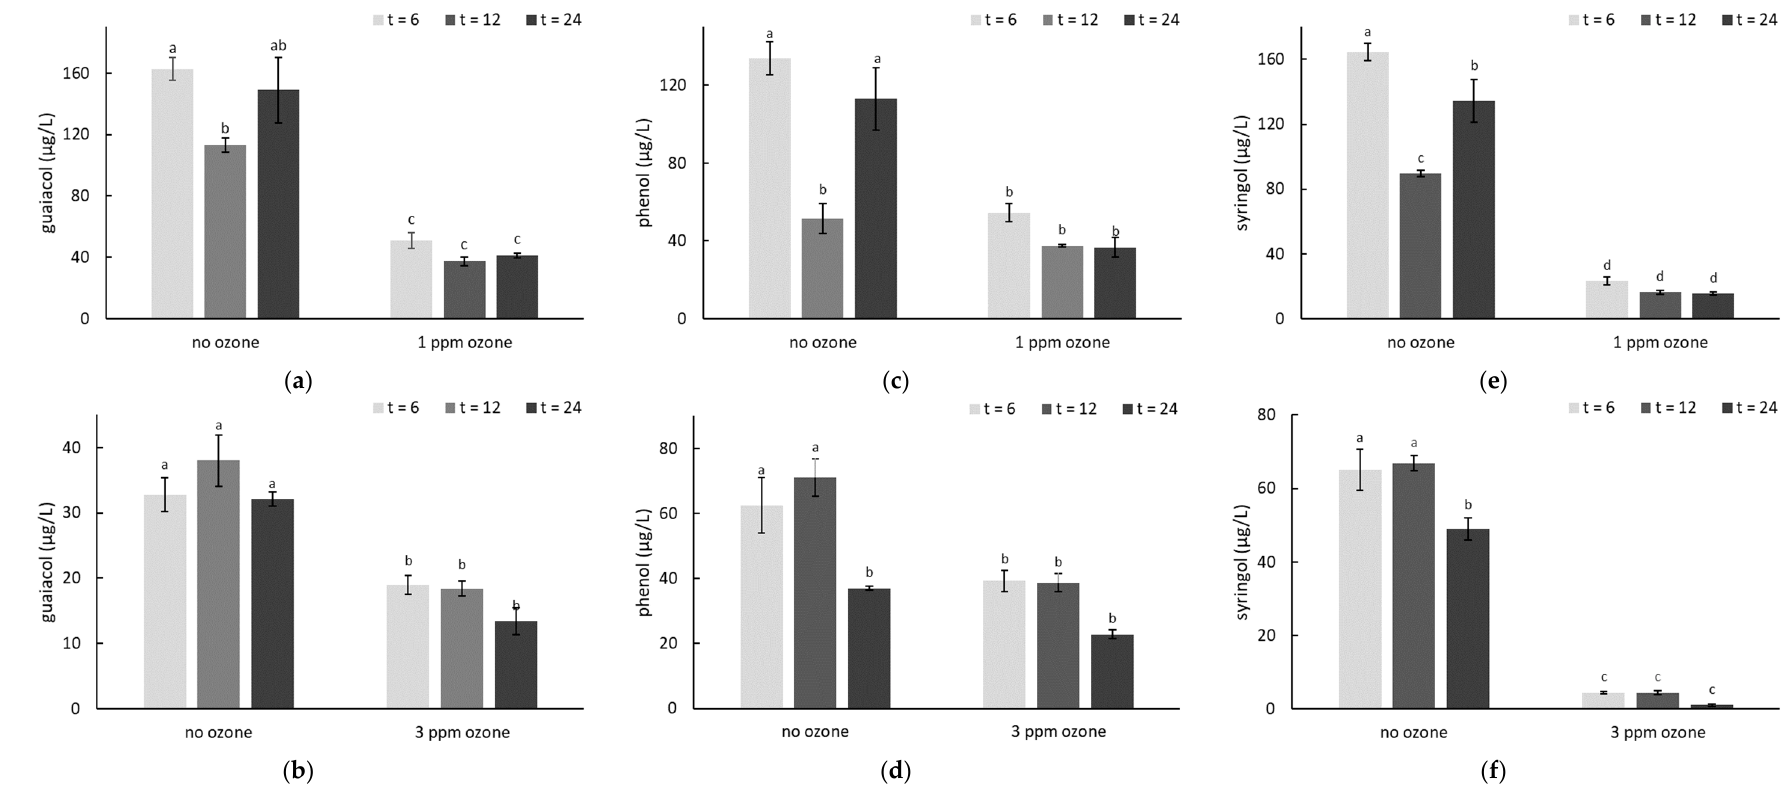
Figure 2. Concentrations ( µ g/L) of ( a , b ) guaiacol, ( c , d ) phenol and ( e , f ) syringol in smoke-affected grapes, with and without ozone treatment (at ( a , c , e ) 1 or ( b , d , f ) 3 ppm for 6, 12 or 24 h).Values are means of three replicates ( n = 3). Different letters indicate statistical significance ( p = 0.05, one-way ANOVA). Post-harvest smoke treatments were applied on consecutive days, but smoke density was lower on the second day of treatment due to increased wind.